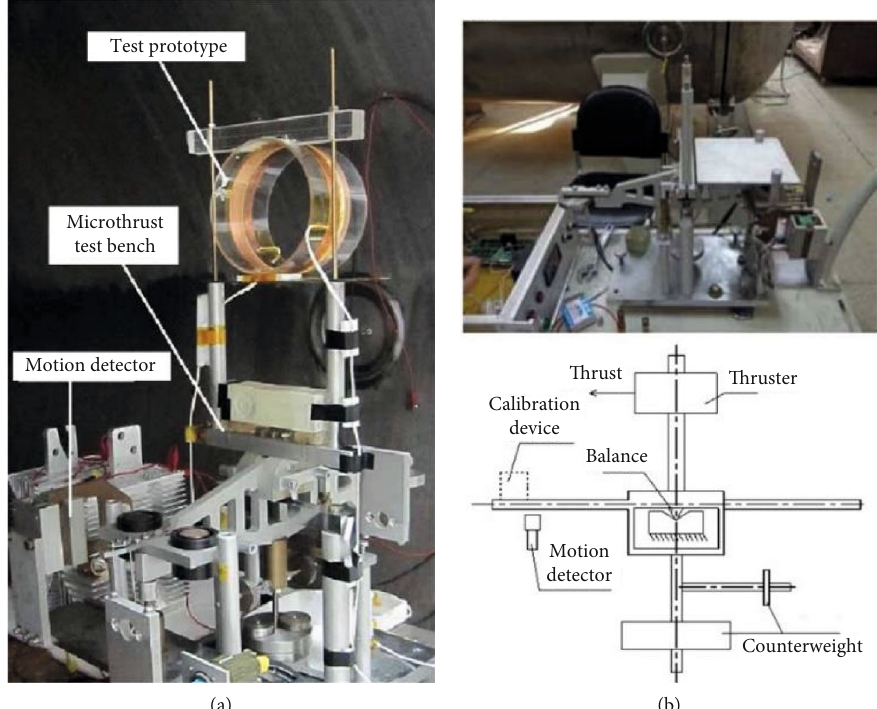
Figure 27: Chen ’ s prototype and test bench: (a) test prototype; (b) test bench of microthrust